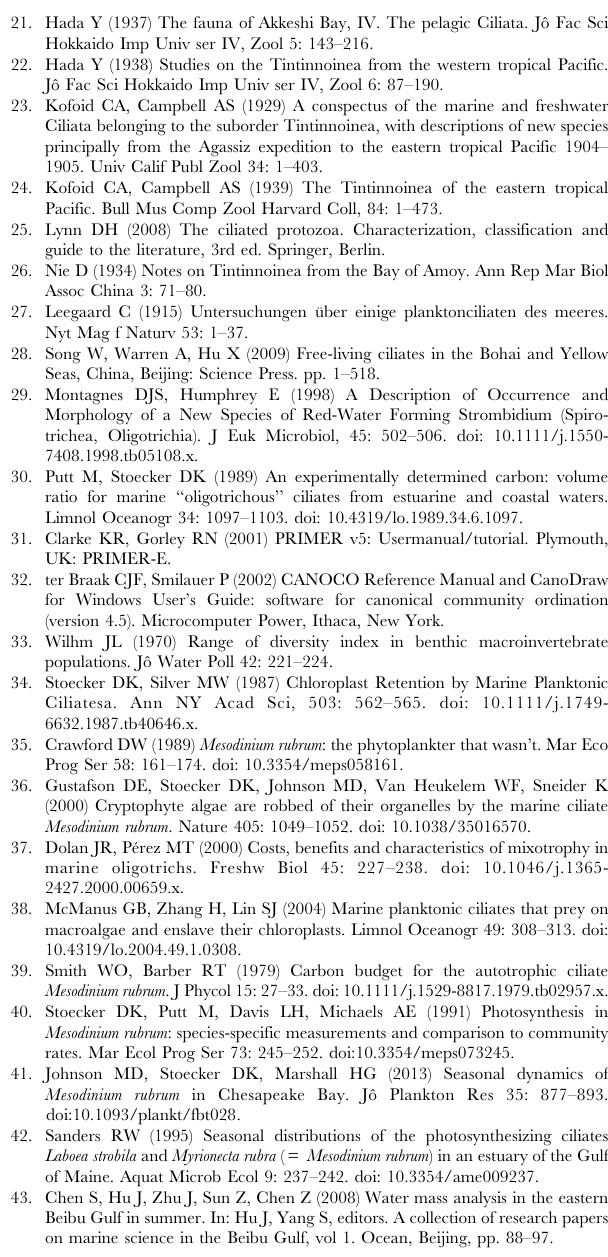
Table S1 List of the ciliate species recorded in multi- layer samples from the northern Beibu